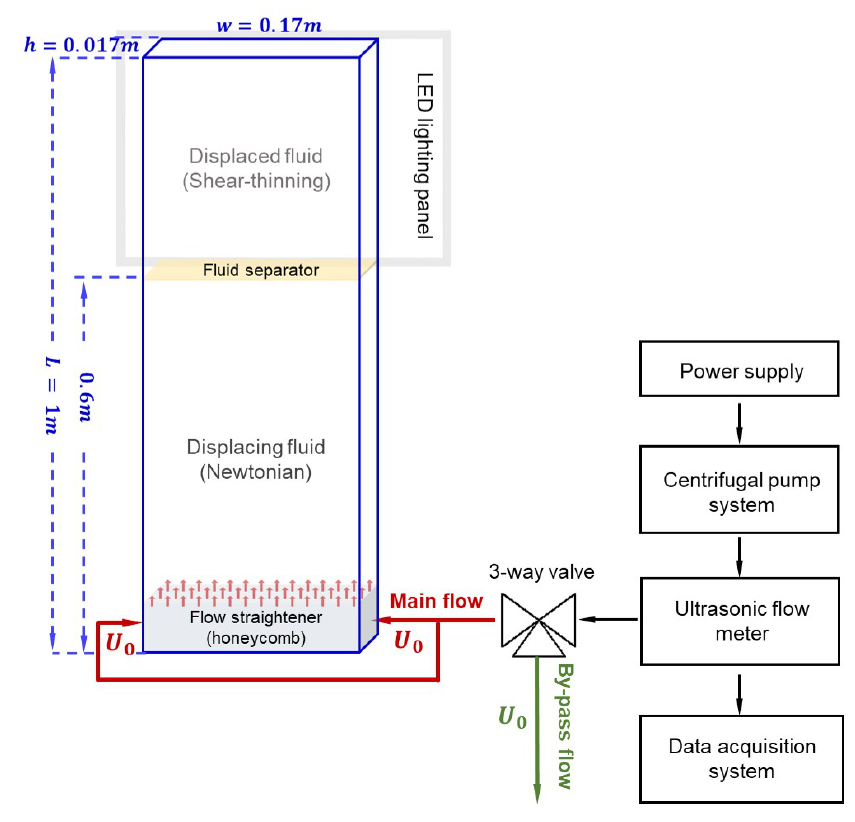
Figure 1. Schematic of the experimental